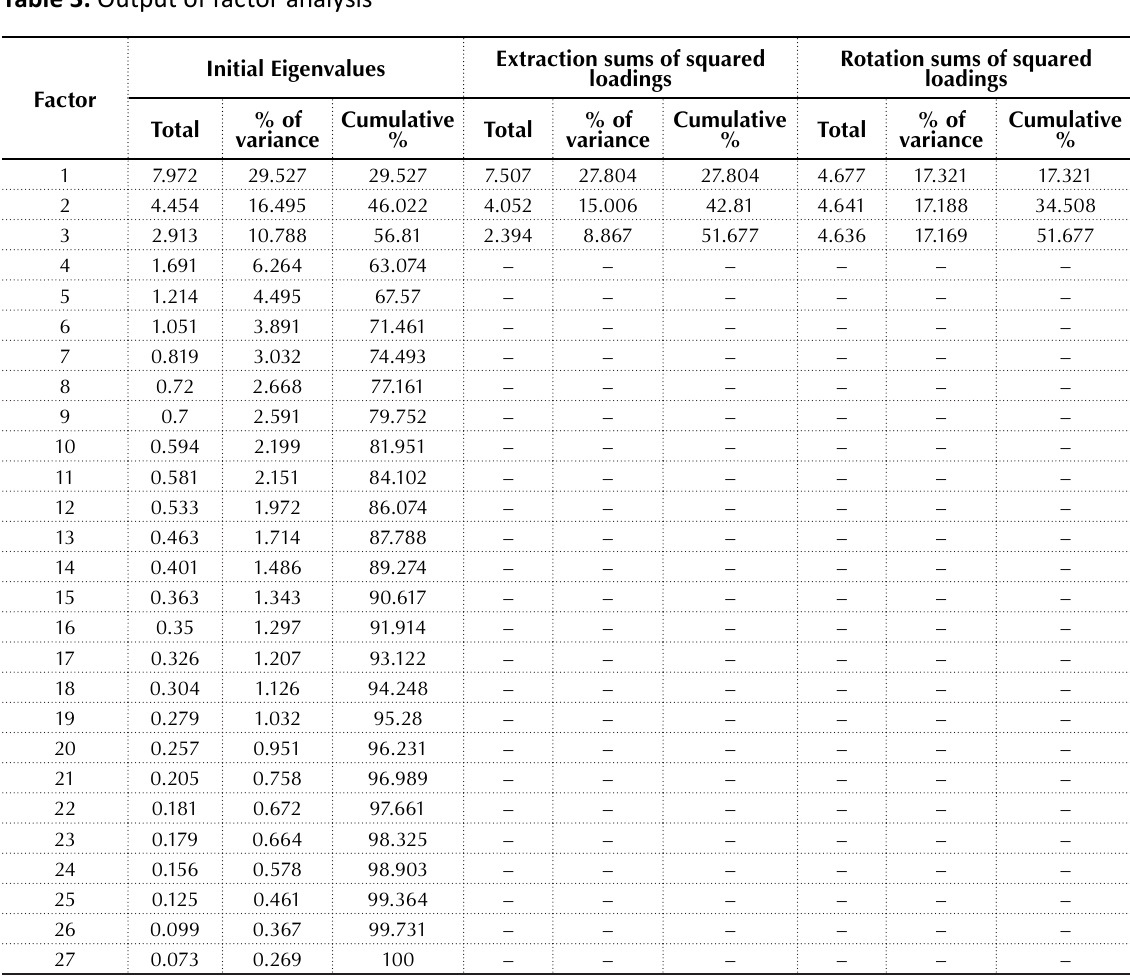
Table 3. Output of factor analysis